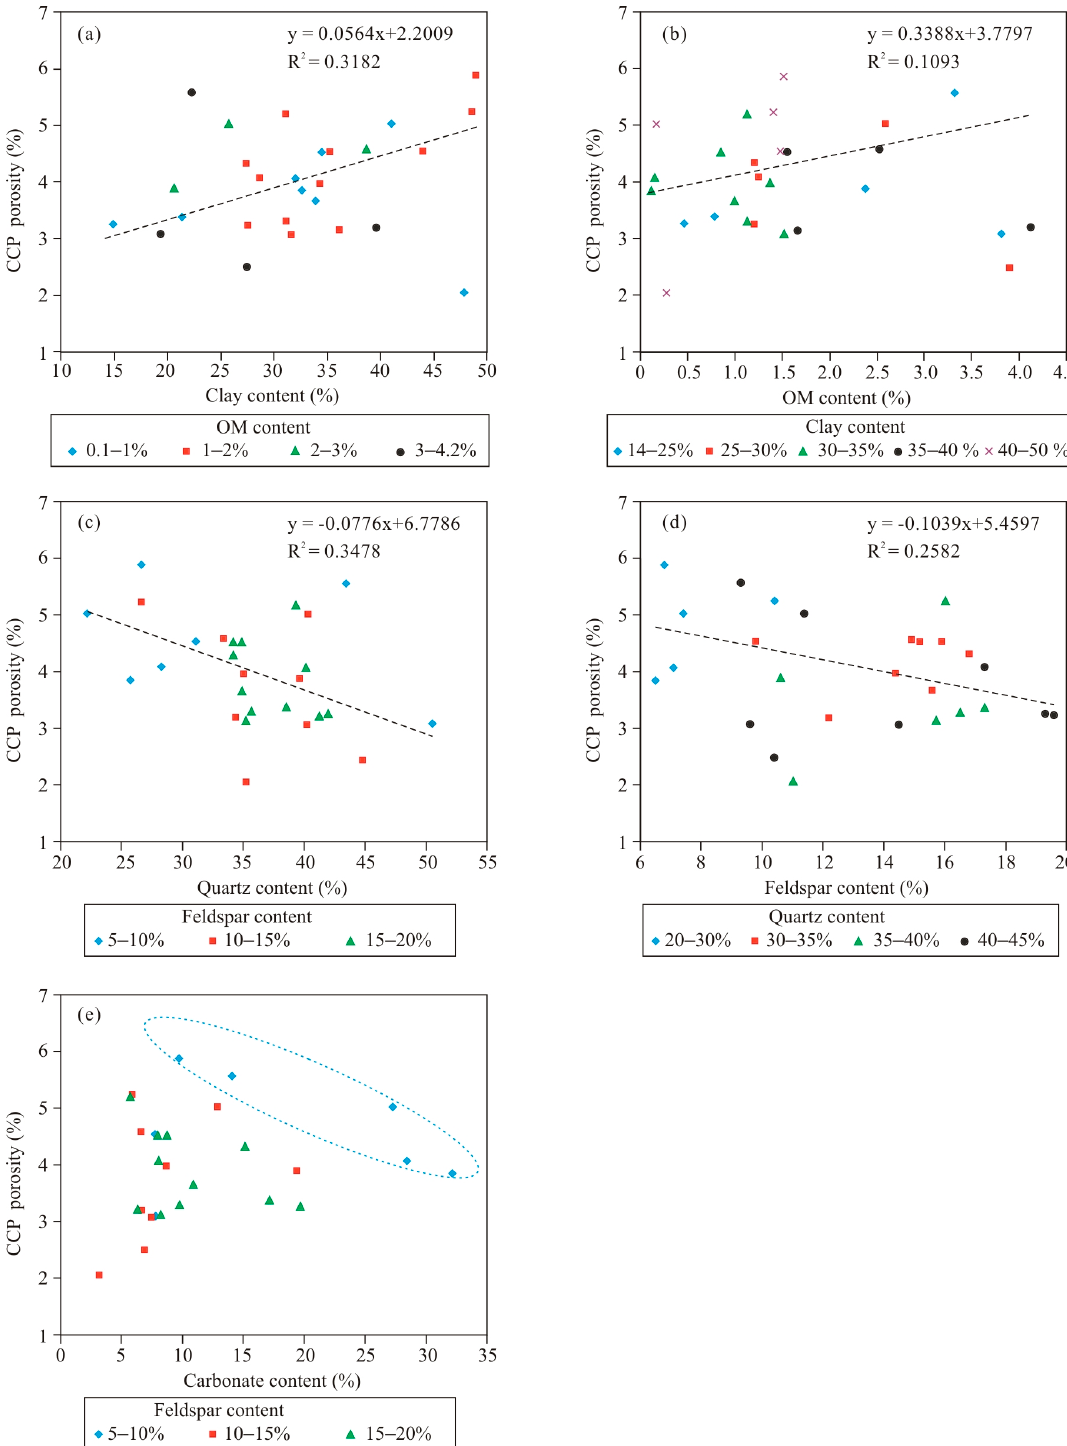
Figure 3. The relationships between CCP porosity values and composition: ( a ) clay content, ( b ) organic matter content, ( c ) quartz content, ( d ) feldspar content, ( e ) carbonate content.